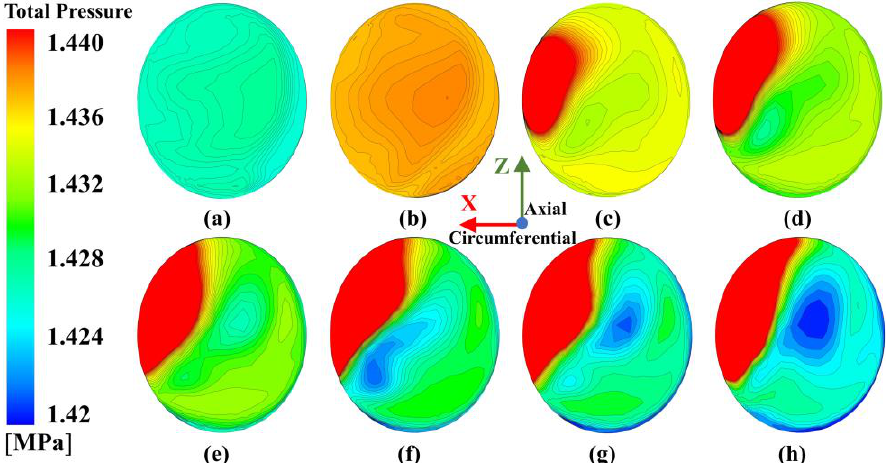
Figure 12. Distribution of total pressure on the middle section of receiving hole at Re = 9.5172 × 10 5 with different nozzle pressure: ( a ) −30% design pressure, ( b ) −20 % design pressure, ( c ) −10 % design pressure, ( d ) design pressure, ( e ) +10% design pressure, ( f ) +20% design pressure, ( g ) +30% design pressure, and ( h ) +40% design pressure.